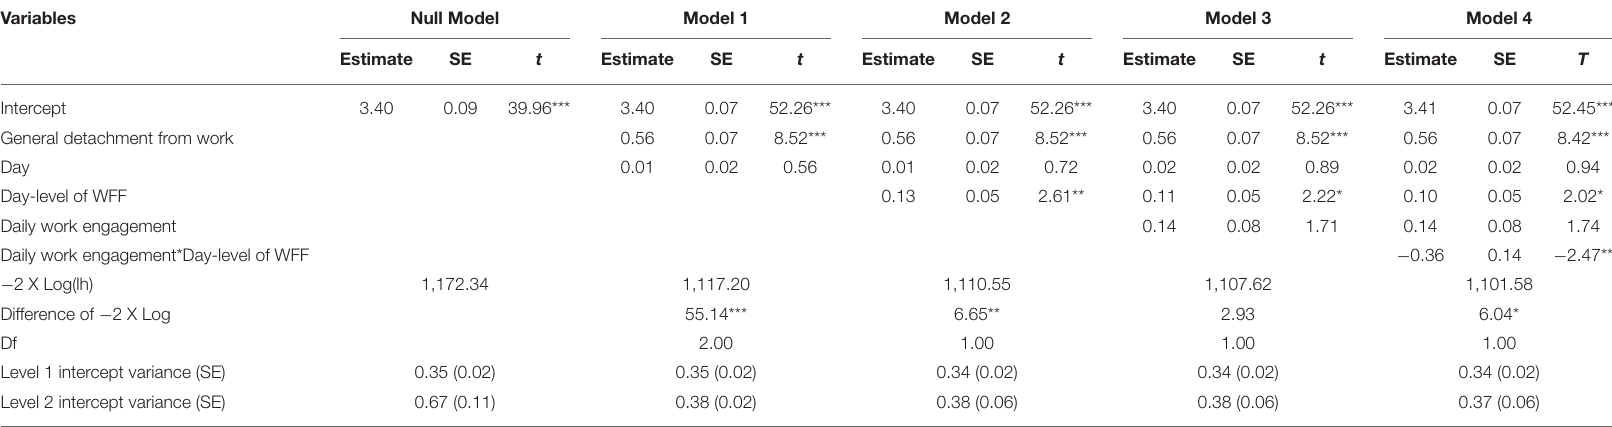
TABLE 2 | Multilevel estimates for models predicting day-level of detachment from work ( N = 520 observations, N = 104 participants).